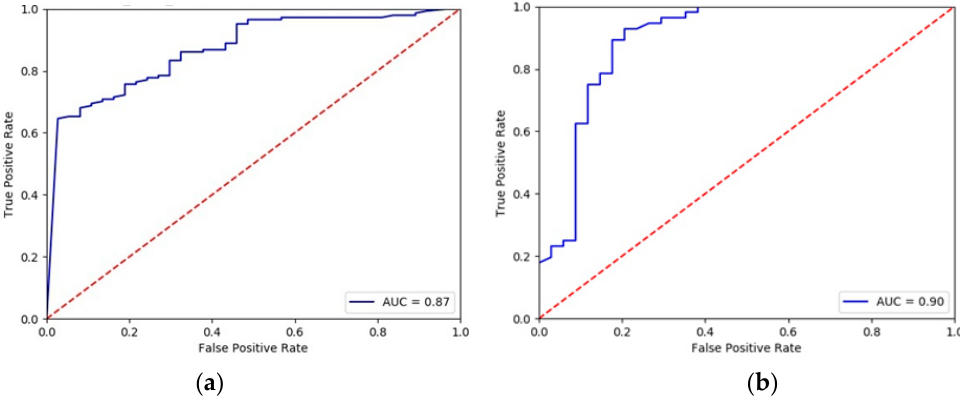
Figure 6. ROC curves for ( a ) Multi-Layer Perceptron and ( b ) Random Forest.